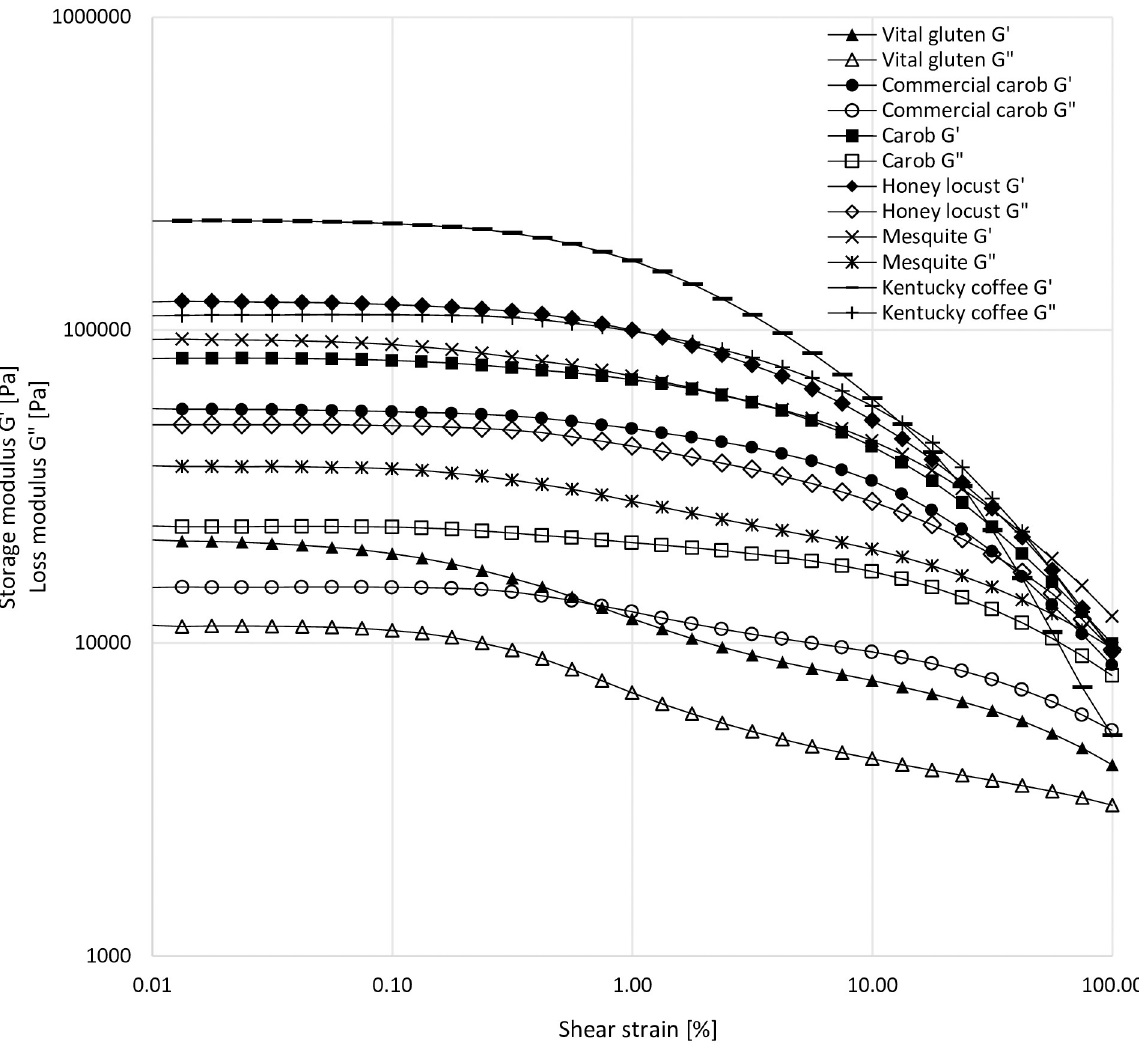
Fig 4. Strain sweep data for the protein samples ( ω = 1 Hz, T =